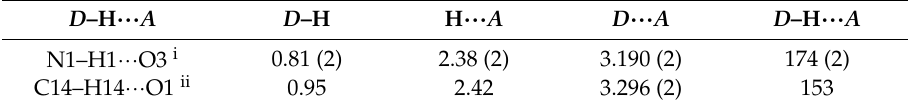
Table 2. Hydrogen-bond geometry (Å, ◦ ) for 25 .